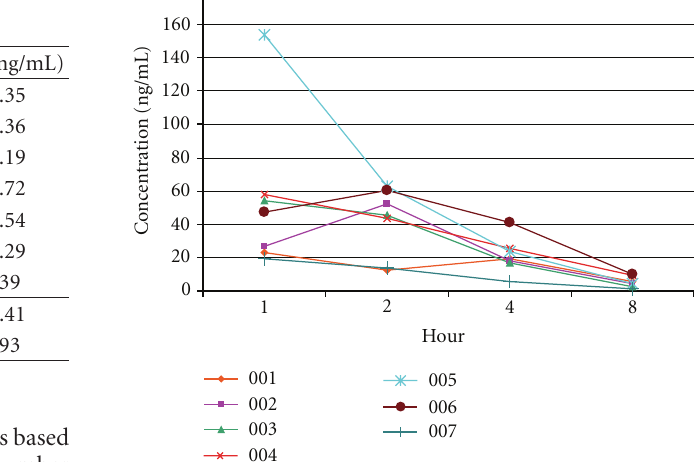
Figure 1: Concentration of 2.5mgs lenalidomide up to eight hours after administration of first